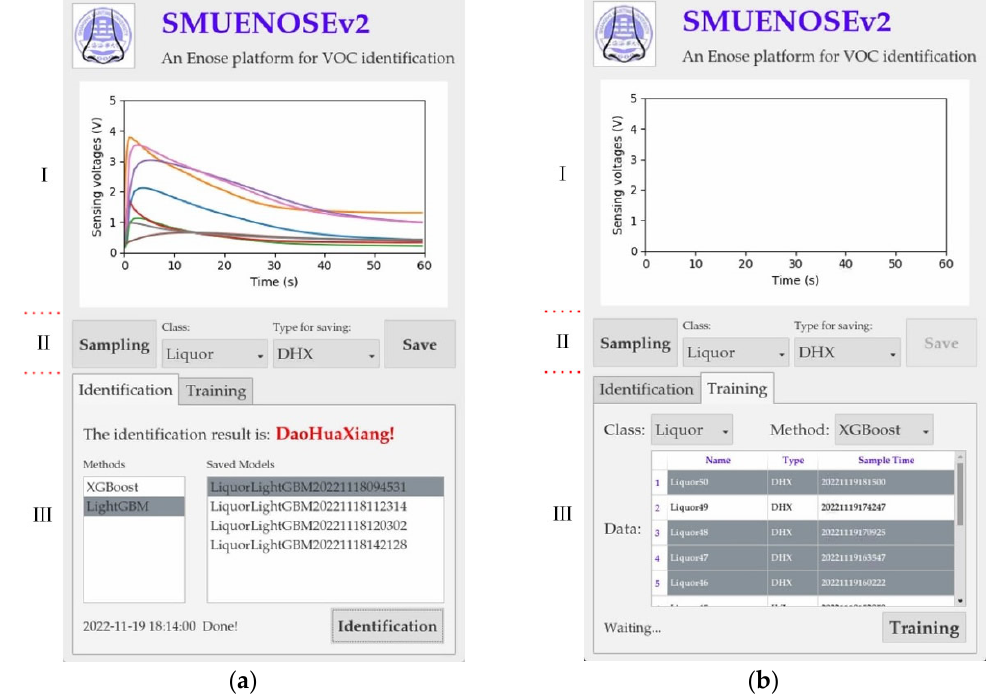
Figure 8. The human–machine interfaces (HMI) of SMUENOSEv2. ( a ) HMI for sampling and identification process; ( b ) HMI for model-training process.